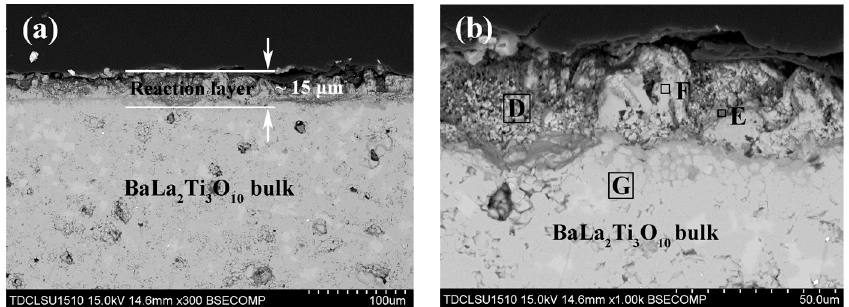
Figure 4. Cross-sectional images of BaLa 2 Ti 3 O 10 ceramic after hot corrosion in Na 2 SO 4 + V 2 O 5 salt at 900 °C for 4 h. ( a , b ) show the images with different magnifications.